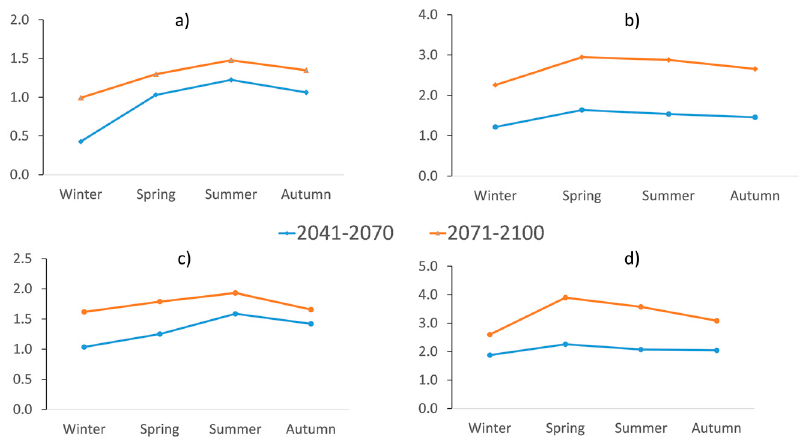
Figure 3. Seasonal temperature change (°C) in ( a ) RCA4_CNRM-CM5 (RCP 4.5); ( b ) RCA4_CNRM-CM5 (RCP 8.5); ( c ) RCA4_EC-EARTH (RCP 4.5); and ( d ) RCA4_EC-EARTH (RCP 8.5). Water 2017 , 9 , 149